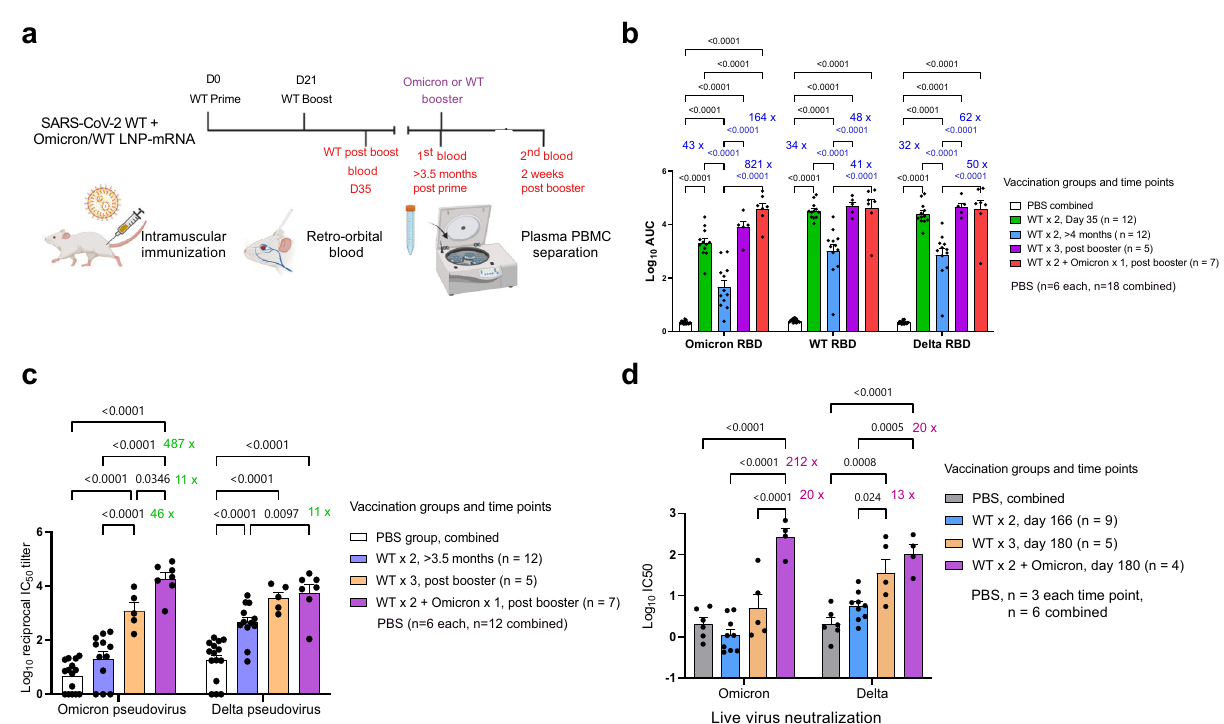
Fig. 3 Heterologous booster with Omicron LNP-mRNA as compared to homologous booster with WT LNP-mRNA in mice that previously received a two-dose WT LNP-mRNA vaccination. a Schematics showing the immunization and blood sampling schedule of mice administered with 1 µ g WT LNP- mRNA prime (WT × 1) and boost (WT × 2) as well as 10 µ g WT or Omicron-speci fi c LNP-mRNA booster shots. The data was collected and combined from two independent experiments shown in Supplementary Fig. 2 and 3. Created with BioRender.com. b Bar graph comparing binding antibody titers of mice administered with PBS or WT and Omicron LNP-mRNA against Omicron, Delta, and WA-1 RBD (ELISA antigens). The antibody titers were quanti fi ed as Log 10 AUC based on titration curves in Supplementary Fig. S1a. PBS sub-groups ( n = 6 each) collected from different matched time points showed no statistical differences between each other, and were combined as one group ( n = 18). c Pseudovirus neutralizing antibody titers in the form of log 10 - transformed reciprocal IC50 calculated from fi tting the titration curve with a logistic regression model ( n = 12 mice before booster, n = 5 in WT × 3, n = 7 in WT × 2 + Omicron). d Infectious virus neutralization titer comparisons between mice before and after vaccination with WT or Omicron boosters ( n = 9 mice before booster, n = 5 in WT × 3, n = 4 in WT × 2 + Omicron). Titer ratios were indicated in each graph and fold change described in manuscript is calculated from (ratio − 1). Data on dot-bar plots are shown as mean ± s.e.m. with individual data points in plots. Two-way ANOVA with Tukey ’ s multiple comparisons test was used to assess statistical signi fi cance. Statistical signi fi cance labels: * p < 0.05; ** p < 0.01; *** p < 0.001; **** p < 0.0001. Non- signi fi cant comparisons are not shown, unless otherwise noted as n.s., not signi fi cant. Sample number is designated as n from biologically independent (Fig. 3b). For both WT and Omicron boosters, the extent of titer increase was more drastic in the Omicron RBD dataset than other RBD datasets, signifying the extra bene fi t of booster shots against Omicron variant (Fig. 3b). The antibody titers did not increase one week after a second booster of Omicron LNP-mRNA (Sup- plementary Fig. 2b).